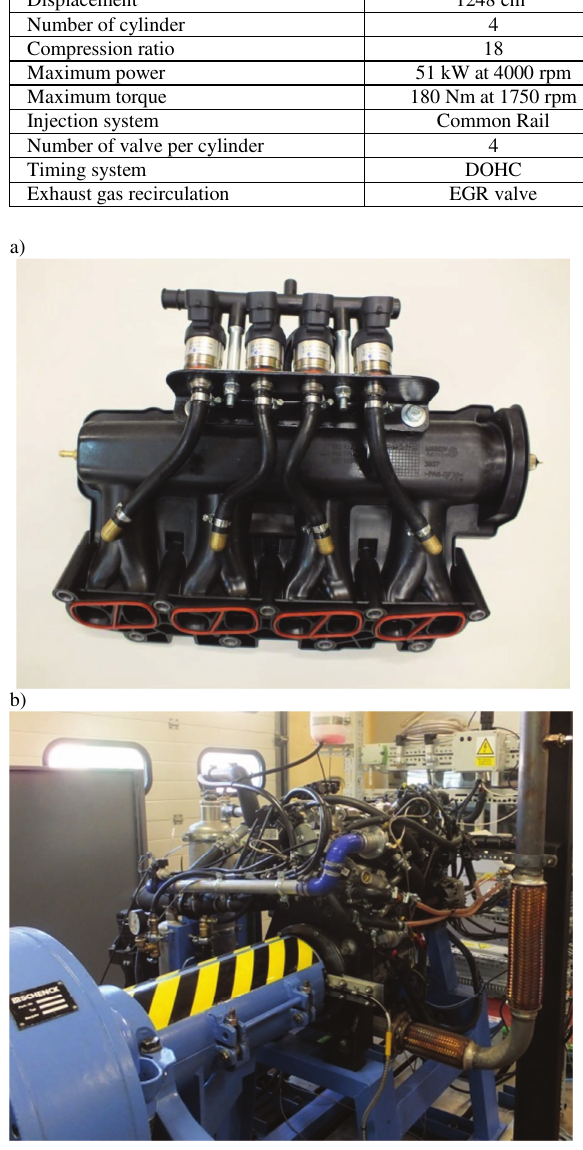
Fig. 2. Intake manifold and test stand of Fiat 1.3 MJT engine:a) intake manifold, b) test stand